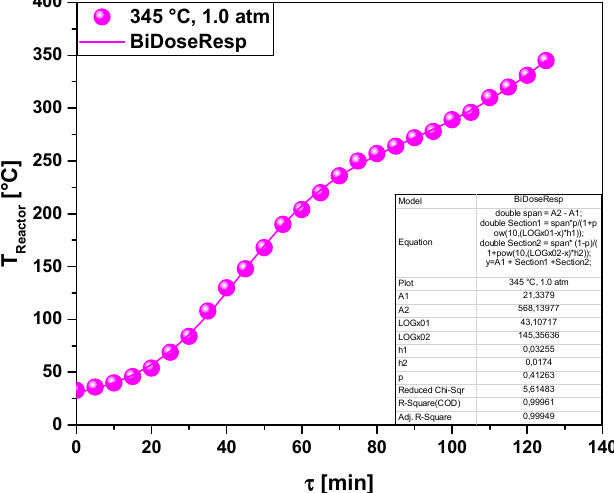
Figure 8. Course of reactor temperature by depolymerization of PMMA based dental resins frag- ments/residues at 345 °C, atmospheric pressure, in pilot scale.